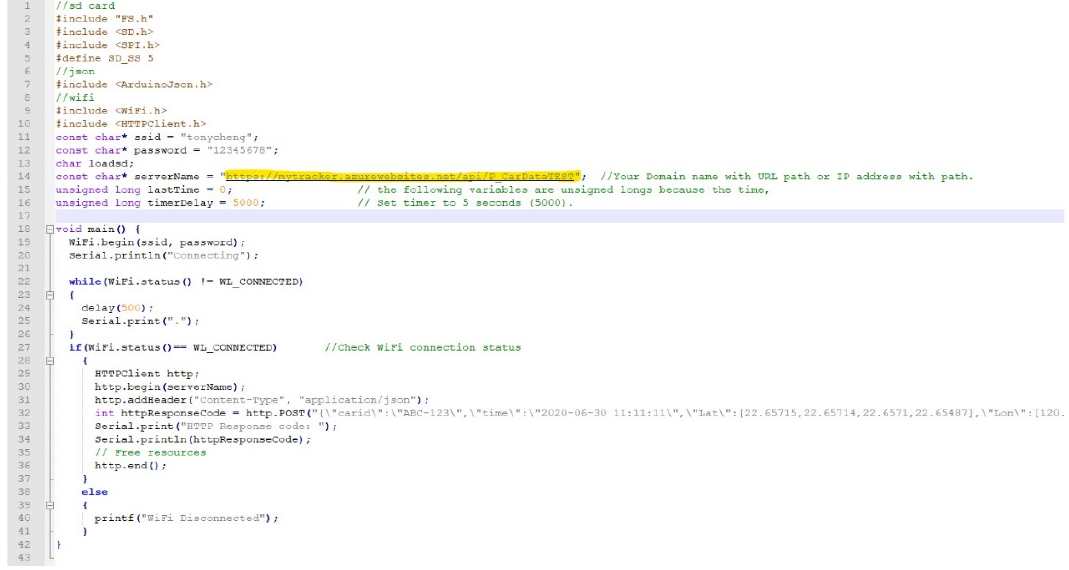
Figure 27. Microcontroller POST request code.